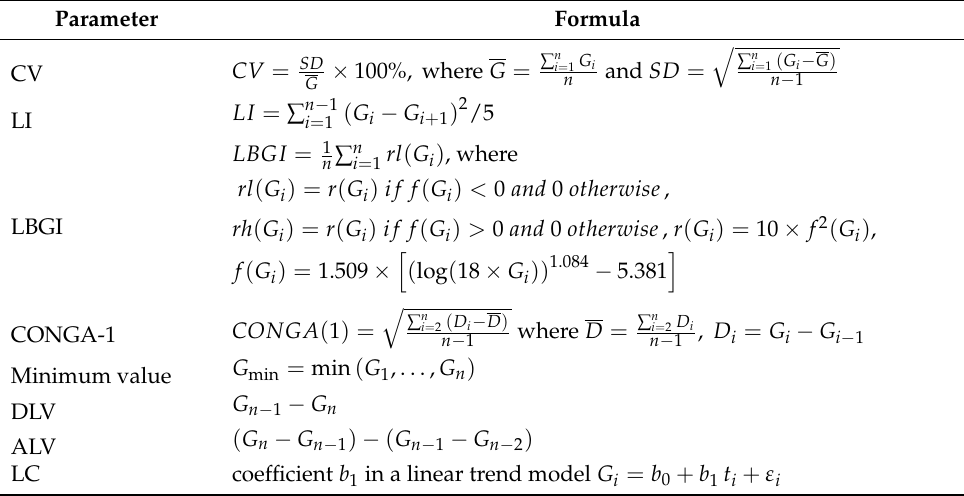
Table 1. CGM-derived metrics used for the engineering of ML